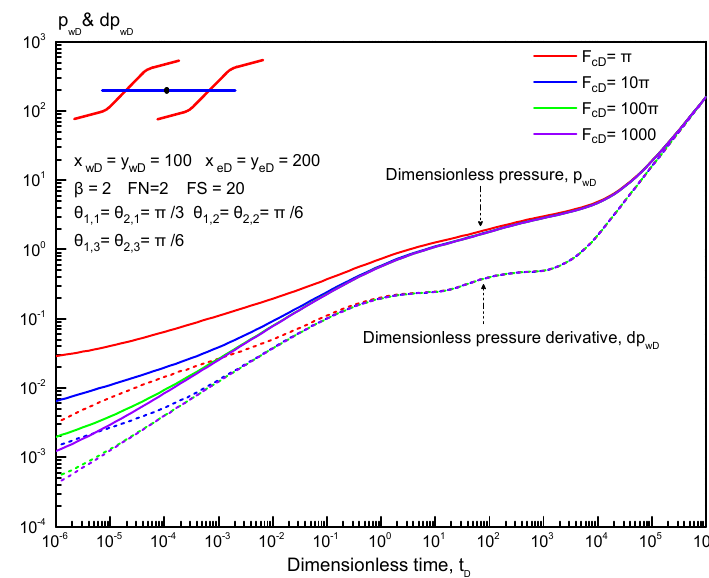
Figure 15. E ff ect of fracture conductivity on pressure and the pressure Figure 15. Effect of fracture conductivity on pressure and the pressure derivative.